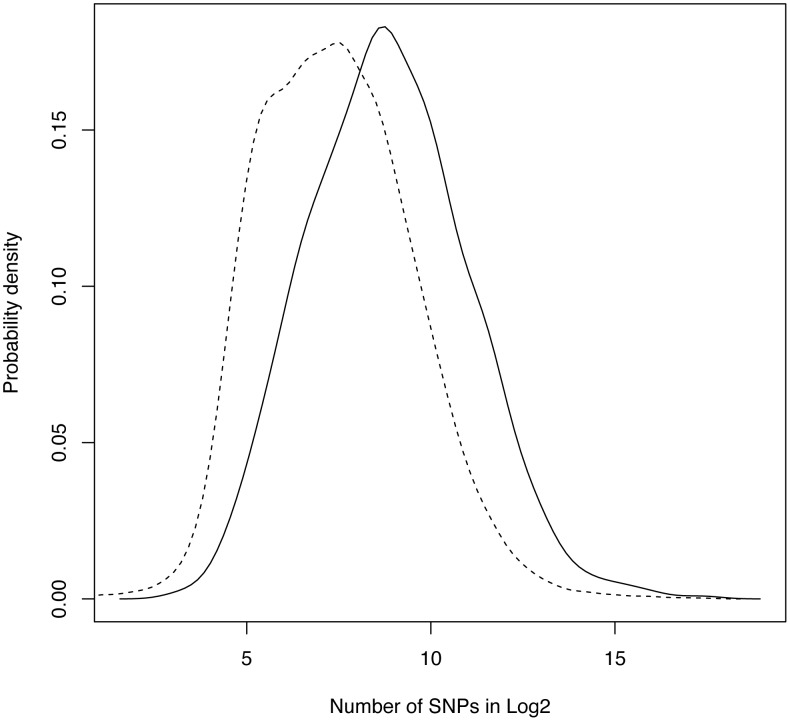
Distribution of the number of SNPs in log2.TRG – solid line, all genes – dashed line.